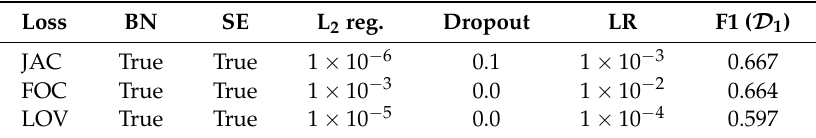
Table A1. Best configurations and F1 scores for loss functions different from binary cross-entropy. Acronyms: BN (Batch Normalization), SE (Squeeze-and-Excitation), L 2 reg. (strength of the L 2 regularization on the network parameters), LR (Learning Rate), FOC (Focal loss), JAC (Jaccard loss), LOV (Lovász-softmax